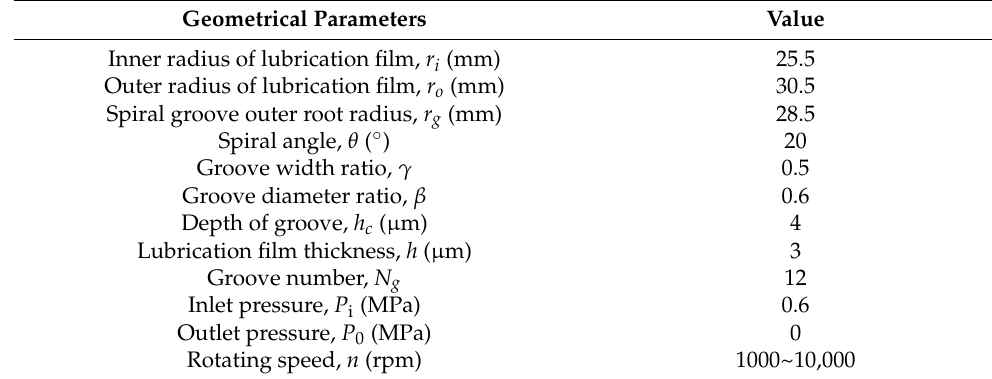
Table 1. Operating conditions for the seal and end face modeling parameters.